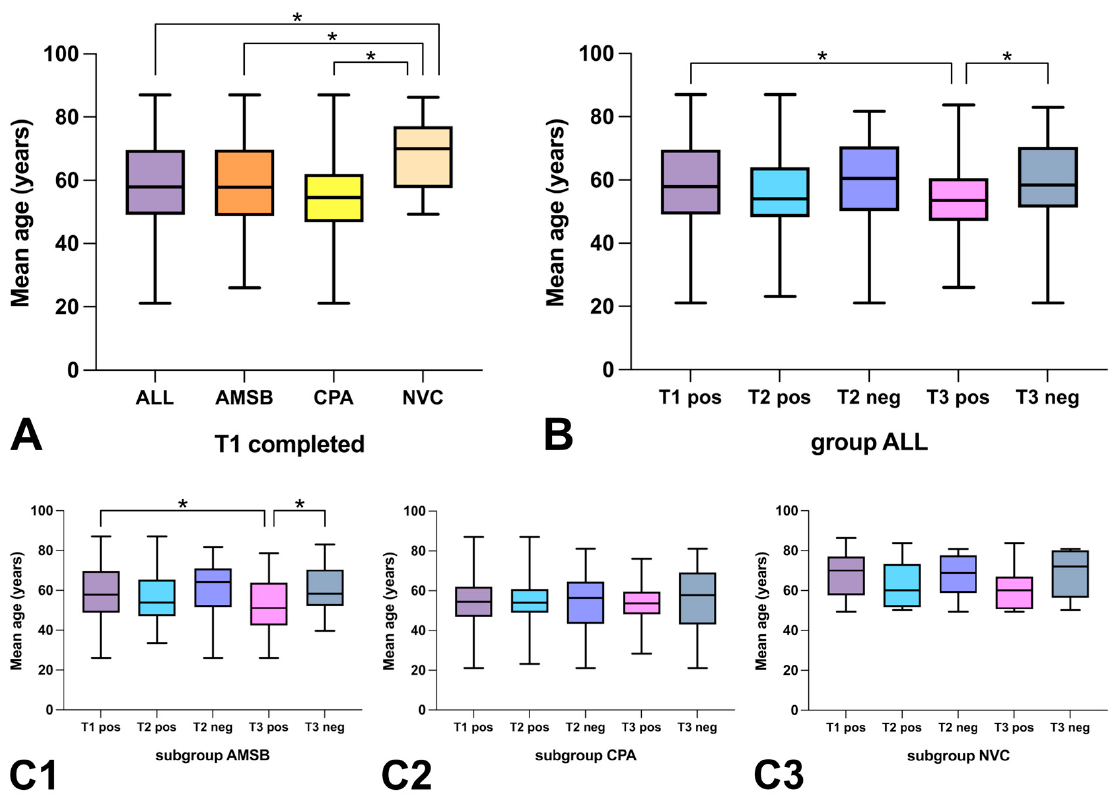
Figure 4. Evaluation of the response rate to PROMs depending on age. (group) ALL = total group, (subgroup) AMSB = subgroup “anterior and middle skull base”, (subgroup) CPA = subgroup “cerebellopontine angle”, (subgroup) NVC = subgroup “neurovascular conflict”, T1 completed/T1 pos = completed initial assessments T1, T2/T3 pos = completed follow-up assessments T2/T3, T2/T3 neg = not-completed follow-up assessments T2/T3, * = statistically significant difference ( p < 0.05). ( A ): Comparison of the mean age of the total group and the subgroups AMSB, CPA, and NVC at initial participation (T1), presented as median values (black horizontal lines) with 25 − 75% percentiles (colored box) and minimum/maximum (black vertical lines). ( B , C ): Comparison of the mean age of par-